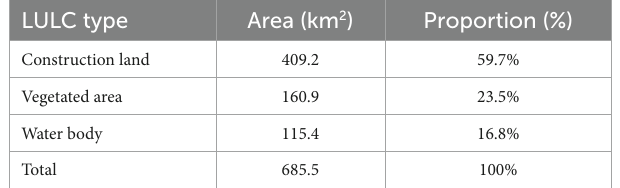
TABLE 1 Area statistics of different LULC categories.